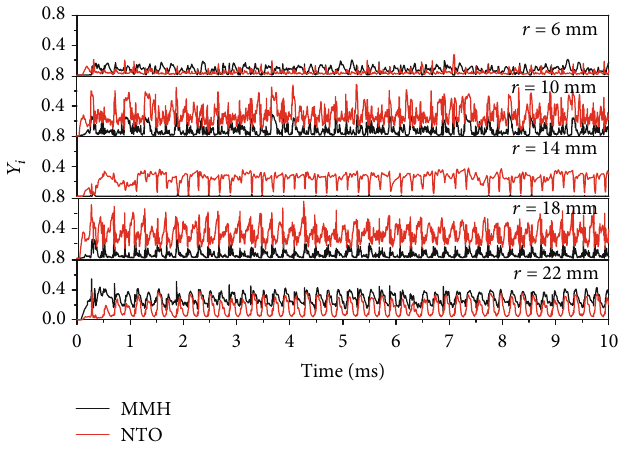
Figure 20: The time histories of mass fraction of MMH and NTO in Case